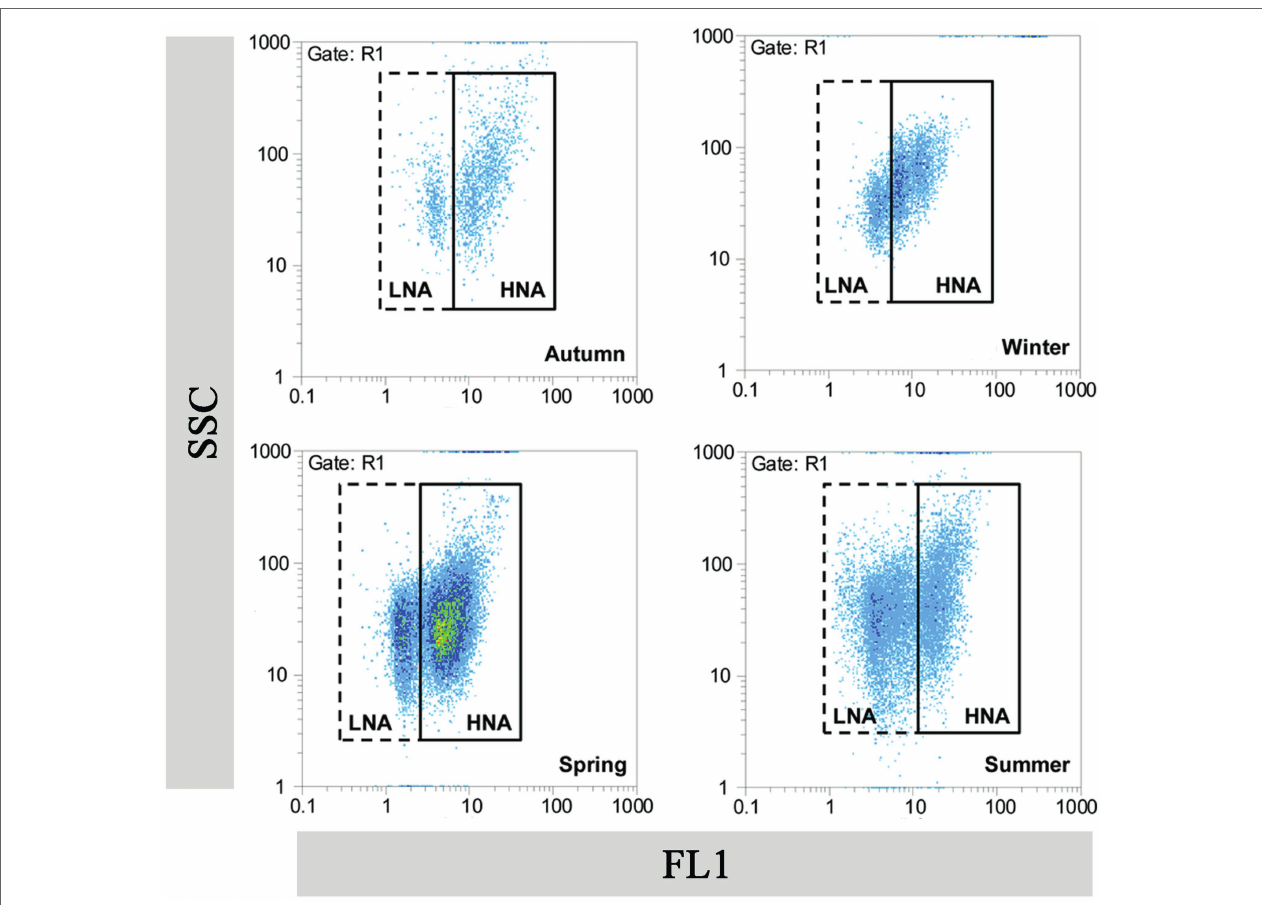
FIGURE 1 | Flow cytogram fingerprint of LNA and HNA bacteria in the Haihe River. This figure is cited from the authors (Liu et al., 2016). FL1, fluorescence intensity; SSC, sideward